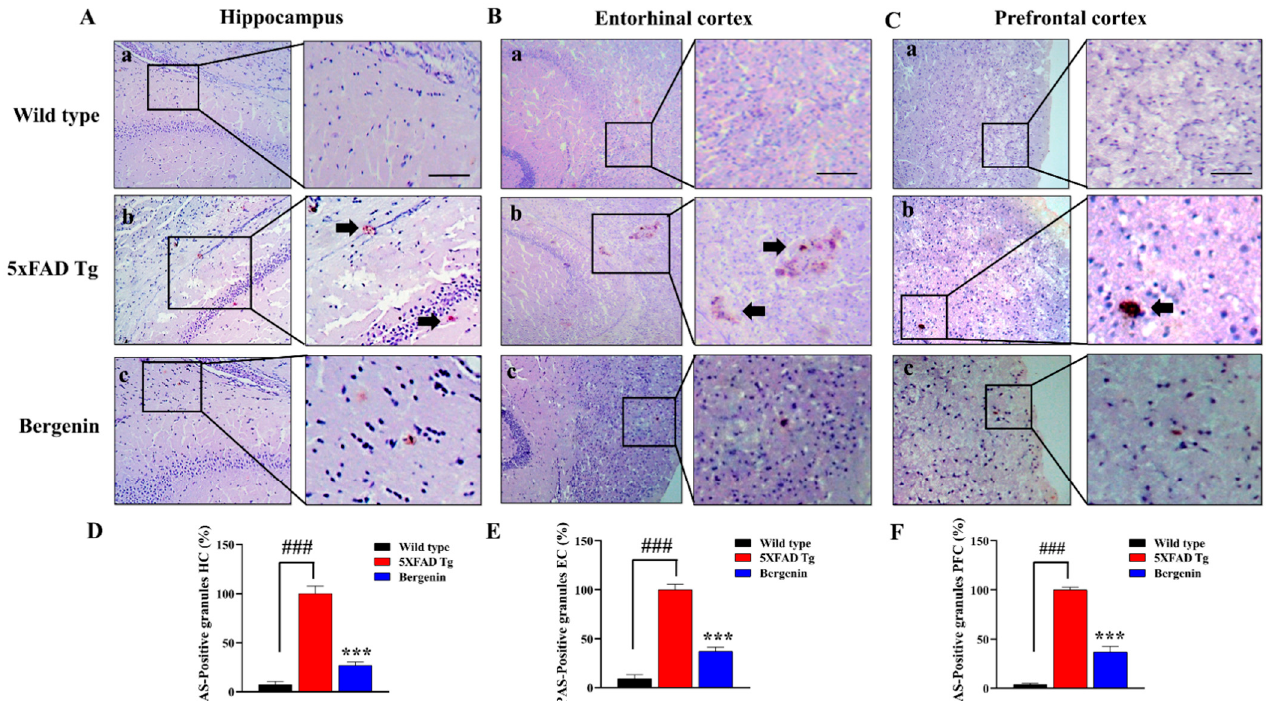
Figure 6. Bergenin (60 mg/kg) demonstrated a decrease in PAS-positive granules (arrows) in all the regions of interest. Representative photomicrographs of ( A ) hippocampal CA2, ( B ) prefrontal cortex, and ( C ) entorhinal cortex region in ( a ) wild-type, ( b ) 5xFAD Tg, and ( c ) Bergenin groups were stained with Periodic acid-Schiff (PAS) in 5xFAD Tg mice. Scale bar = 50 µm. ( D – F ) Quantitative analysis results were expressed as mean ± S.D. *** p < 0.001 versus the 5xFAD Tg group, ### p < 0.001 versus the wild-type group.